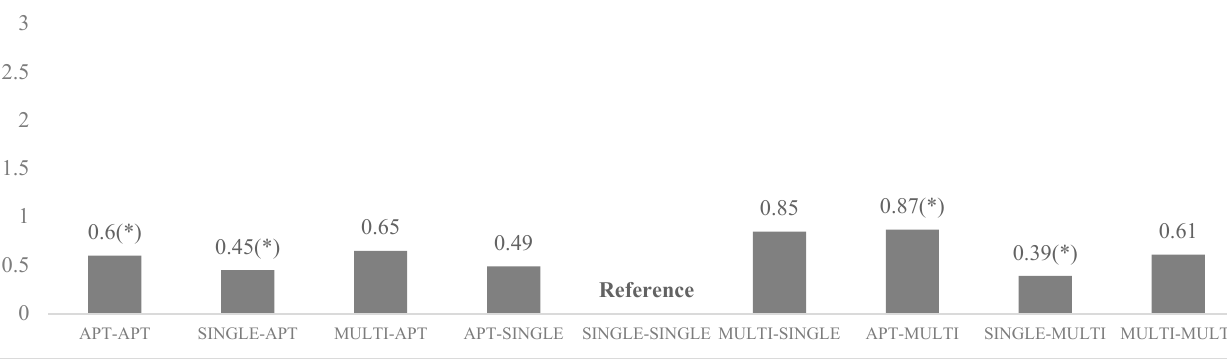
Figure 6. Interaction effect (odds ratio) in MLIM with reference to SINGLE-SINGLE. Note: * denotes rejection of the hypothesis at the 0.1 (10%) level.